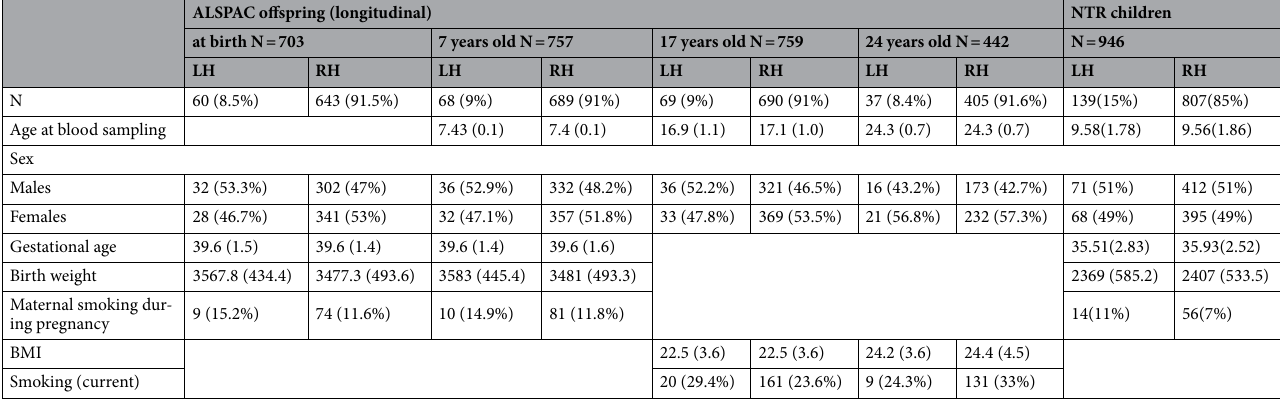
Table 2. Characteristics of the datasets included in secondary analyses. NTR Netherlands Twin Register (buccal cell DNA methylation); ALSPAC Avon Longitudinal Study of Parents and Children (cord blood and whole blood DNA methylation); LH left-handed; RH right-handed; BMI body mass index. Numbers in EWAS basic models are reported. Values are presented as mean (SD) or n (%). Current smokers in ALSPAC were defined as those with cg05575921 methylation below 0.82 (see